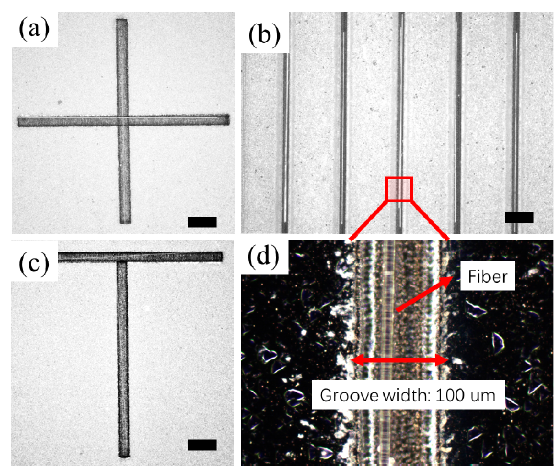
Figure 9. Demonstration of orderly distribution and alignment of microfibers on